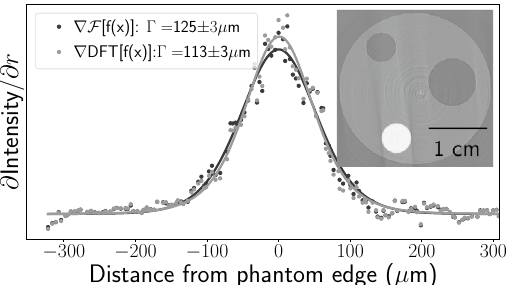
Figure 6. Pearson VII fit comparison of spatial resolution achieved through a PM and GPM application of the Beltran two-material phase retrieval algorithm, featuring a PMMA phantom with aluminium inset. Data was recorded using the LAMBDA detector at a propagation distance of 2m , and spatial resolution analysis was performed using the aluminium-PMMA material